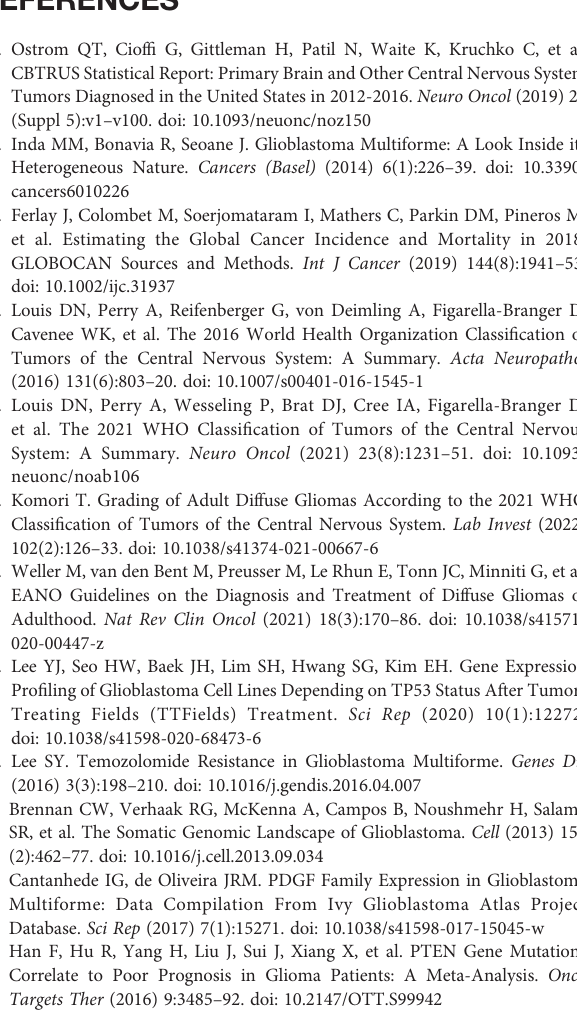
Supplementary Figure 3 | Genomic alteration identi fi ed in analyzed diffuse gliomas Summary of genomic alterations detected by the Glio-DNA panel and investigated. Samples are subdivided into groups dependent on diagnostic pro fi le. Single amino acid substitutions are shown in red, truncations in grey, copy number ampli fi cations or deletions in blue and orange, respectively. Sample 6 is a case of gliosarcoma while sample 37 is a case of diffuse midline glioma. The letter “ X ” indicates not available data. GBM: glioblastoma; A: astrocytoma; O: oligodendroglioma; GGG: